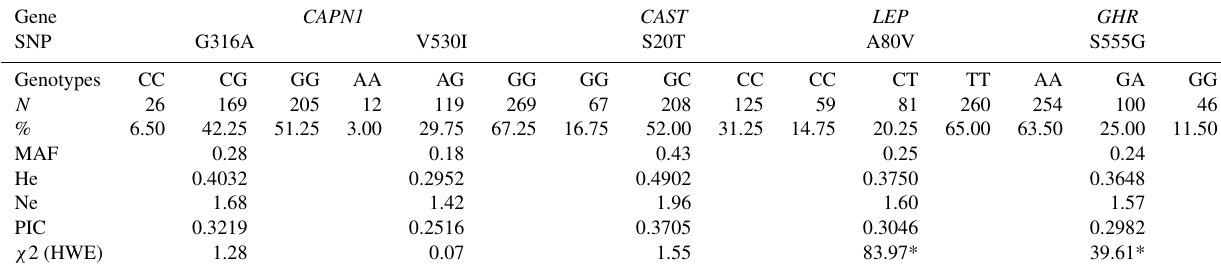
Table 2. Gene frequencies, population genetic indices and HWE test of polymorphisms in the CAPN1 , CAST , LEP and GHR genes in a Holstein population. Gene CAPN1 CAST LEP GHR SNP G316A V530I S20T